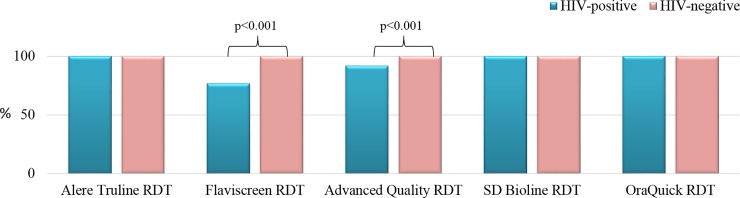
Sensitivities of anti-HCV rapid diagnostic test kits by HIV sero-status.